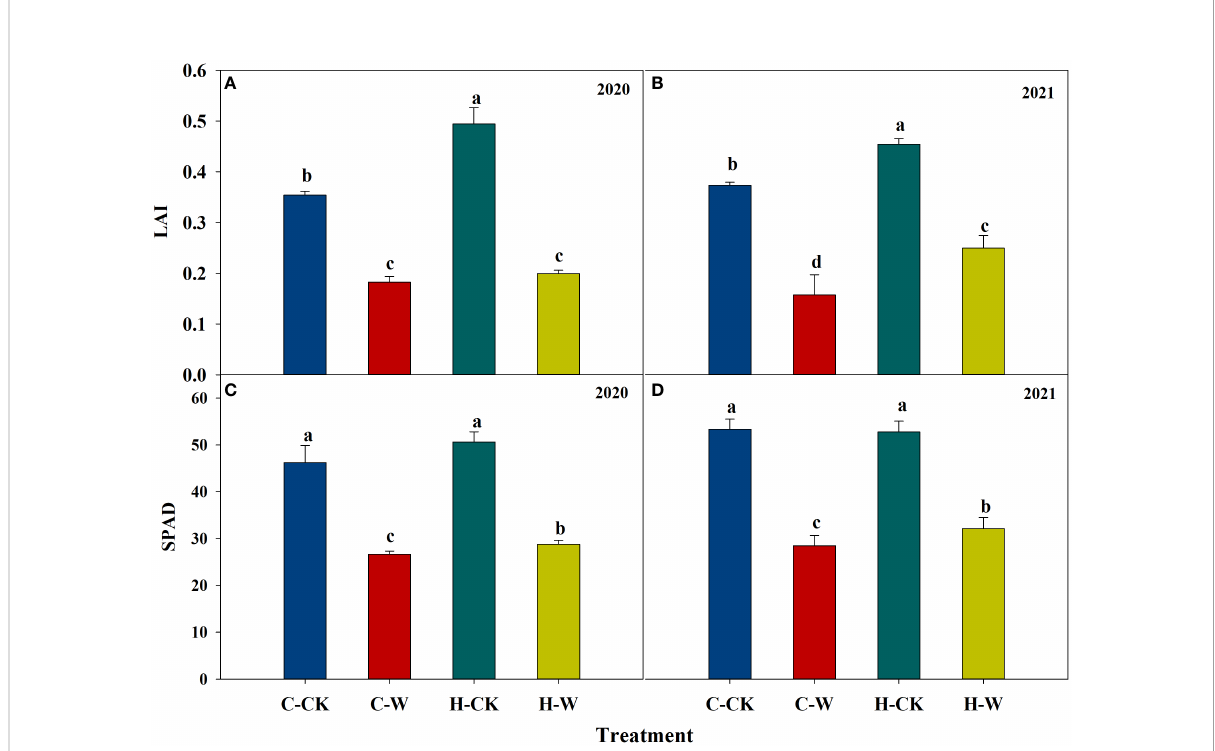
FIGURE 3 Leaf area index and Soil and plant analyzer development (SPAD) value. (A, B) Leaf area index in 2020 and 2021; (C, D) Soil and plant analyzer development (SPAD) value in 2020 and